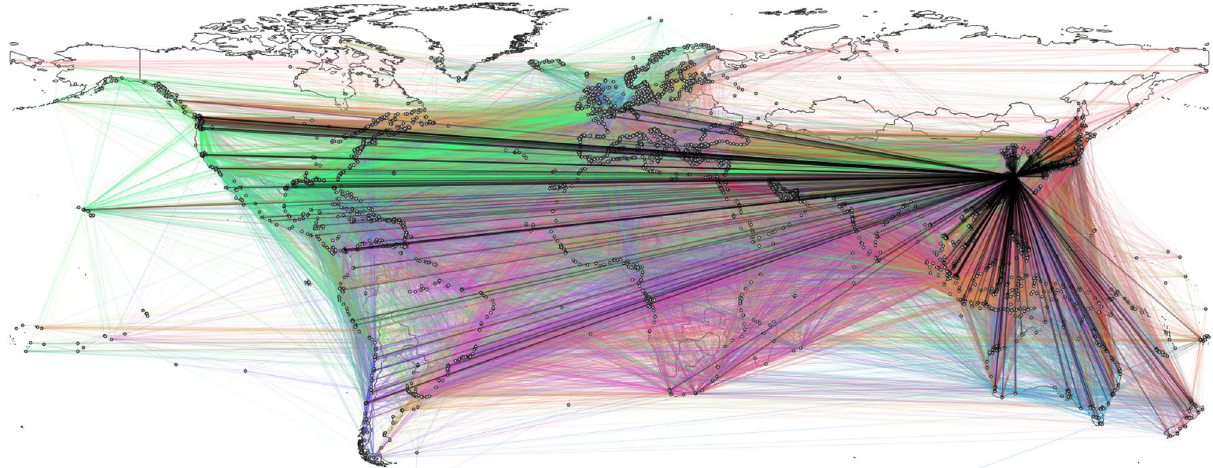
Figure 3. Representation of Shanghai’s ego network and its 3-step neighborhood: each port in the picture, represented by a circle on the coastline, is reachable from Shanghai with at most three hops. An ego network 34 consists of a focal node (the ego ) and the nodes (the alters ) that are connected to it, either directly or within a fixed number of steps. The edge color is representative of the country of the port of origin. The plecticity of the underlying graph is 256.04 and its maximum and average normalized betweeness centrality values are equal to − 4 0.128472 and 5.02 × 10 ,